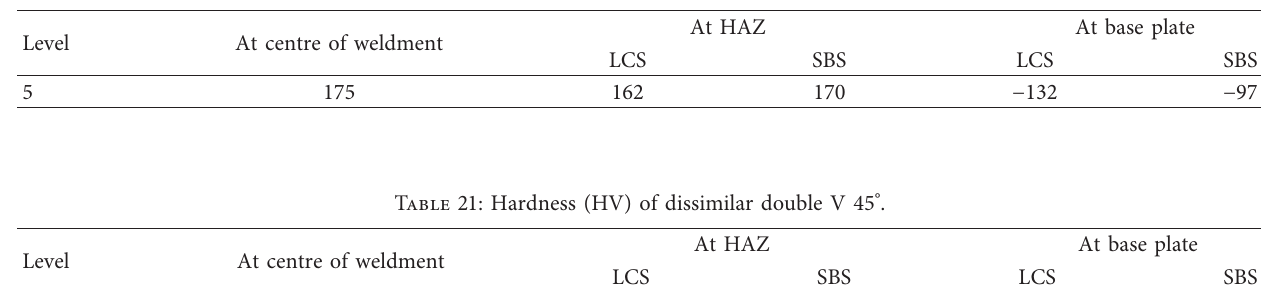
Table 20: Residual stresses (MPa) of dissimilar double V 45 °